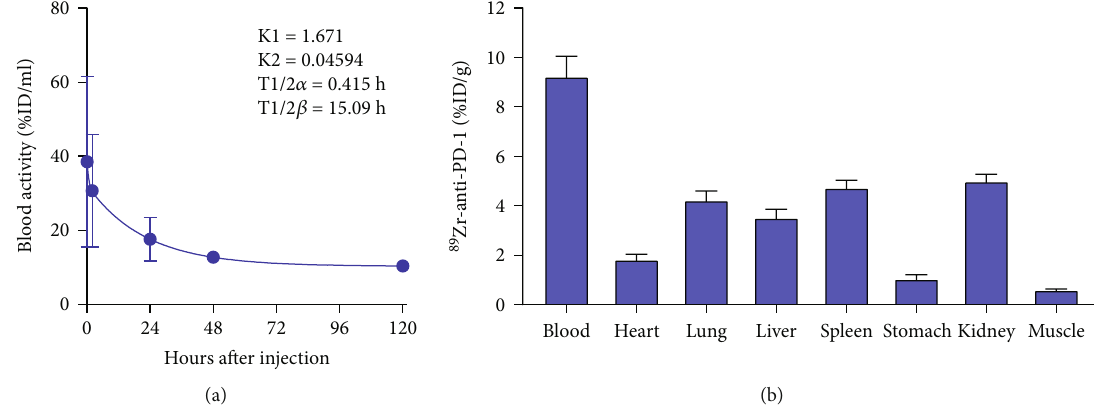
Figure 2: In vivo pharmacokinetics and biodistribution. (a) Time-dependent blood clearance of 89 Zr-PD-1 IgG following intravenous injection into normal Balb/C mice. Curve fi tting by two-phase decay shows biexponential blood clearance that derives pharmacokinetic parameters of early and late rate constants (K1 and K2) and half-lives (T1/2 α and T1/2 β ). (b) Biodistribution of 89 Zr-PD-1 IgG in normal Balb/C mice at 5 days after intravenous